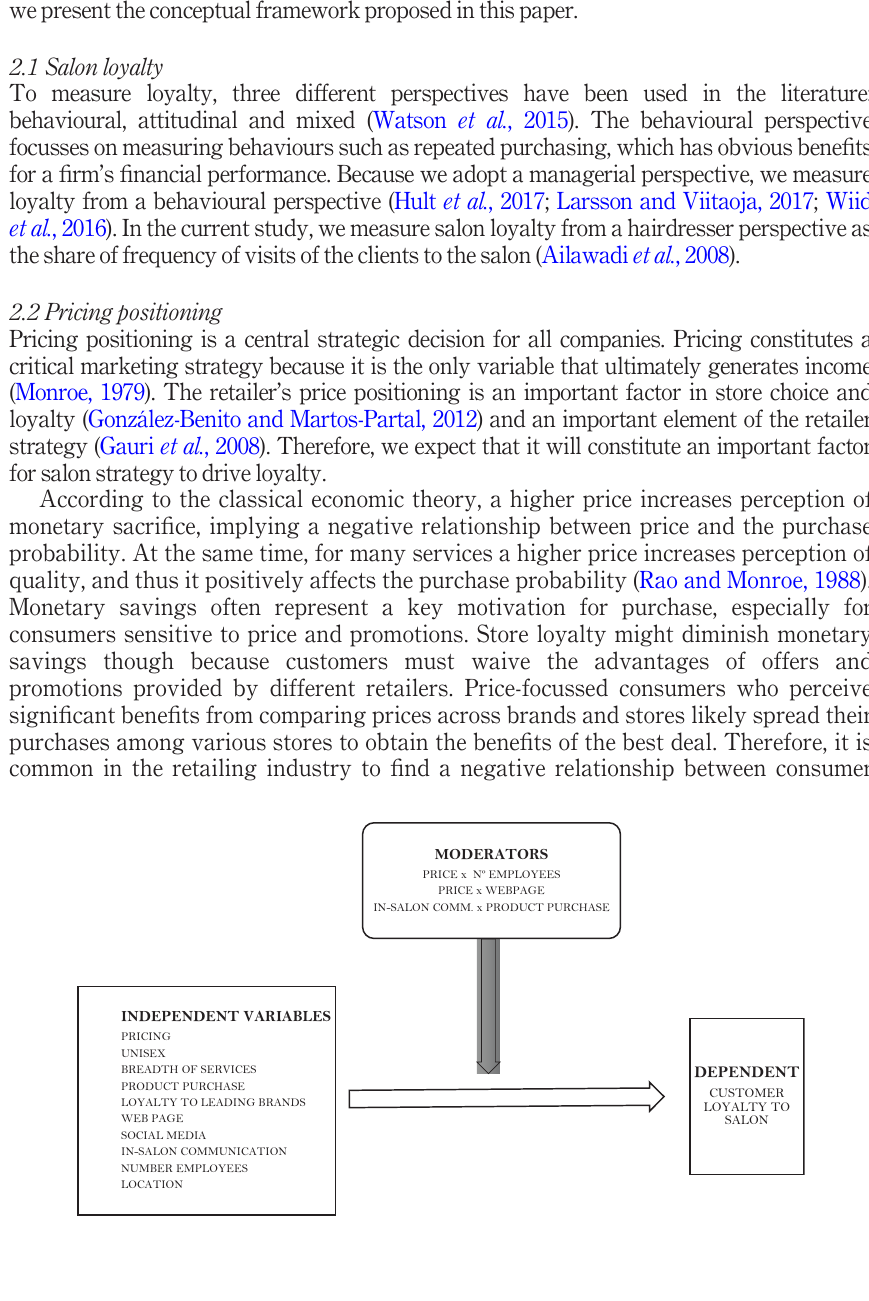
DEPENDENT CUSTOMER LOYALTY TO SALON